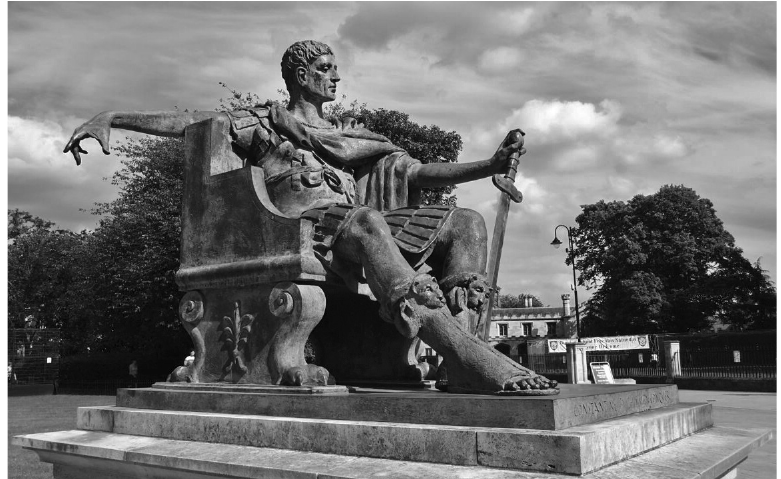
Figure 1: Philip Jackson’s statue of Constantine at York (author’s